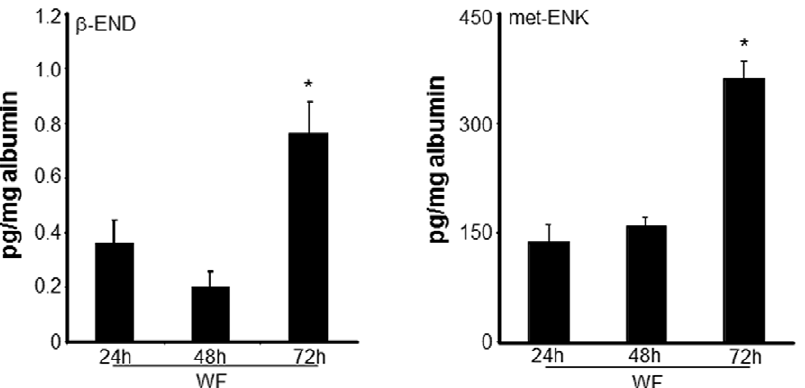
Figure 6. Increased endogenous opioid peptide levels in wound fluid at late inflammatory phase. Wound fluid (WF) was obtained from sternal wounds. Opioid peptide b -endorphin (END) and met-enkephalin (ENK) levels in WF was determined using ELISA at the indicated time points after surgery. The peptide levels were normalized to total albumin level in the fluid. Data are mean 6 SD (n=5).* p , 0.05 compared to 24 h post-